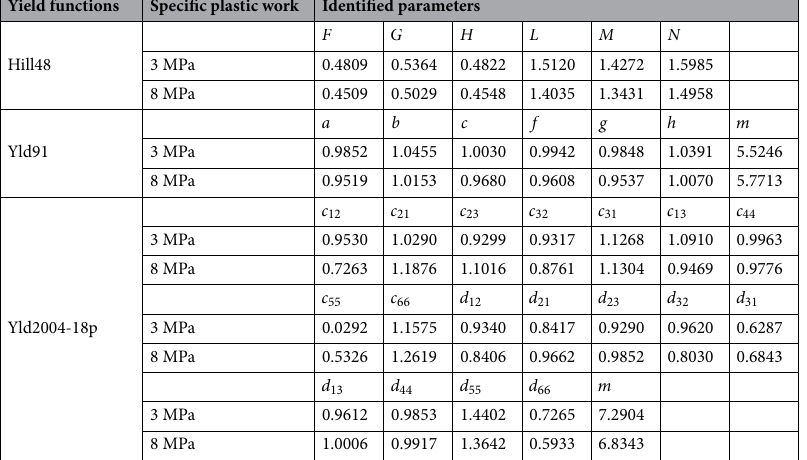
Table 2. The optimal parameters of the calibrated Hill48, Yld91, and Yld2004-18p yield functions for the DP980 sheet.